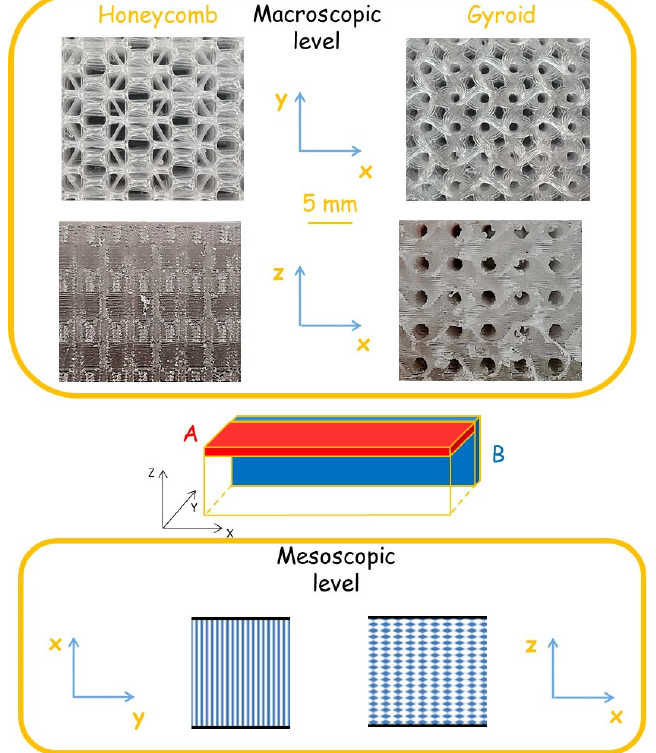
Figure 1. The peculiarities of the multiscale structure of flexible TPU lattice materials with honey- comb and gyroid architecture as well as the arrangement of A- and B-type test